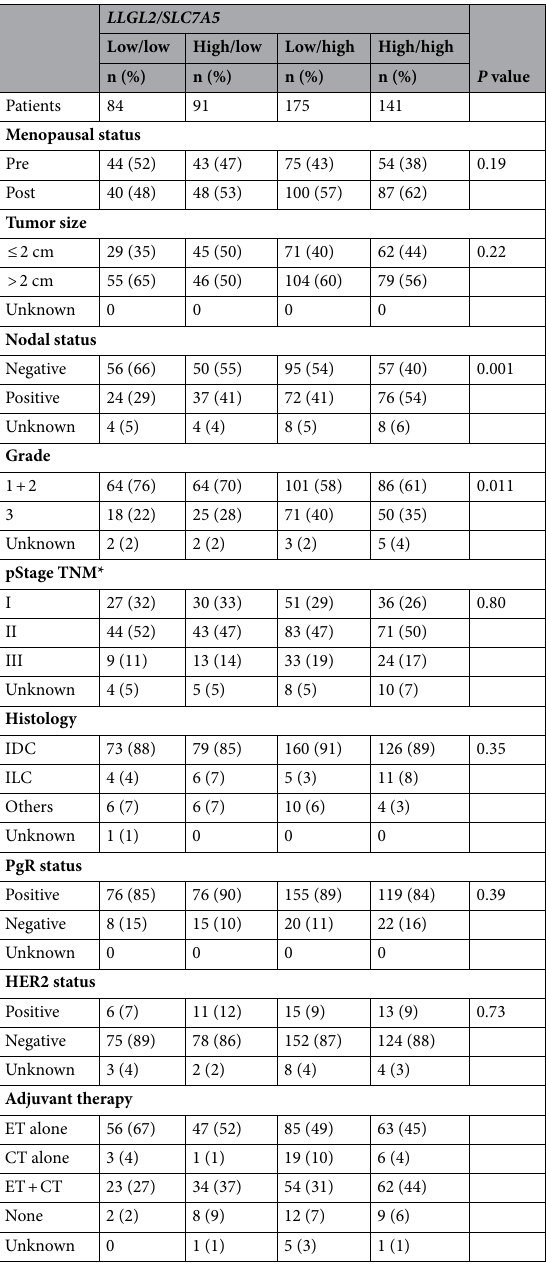
Table 1. Association between LLGL2 and SLC7A5 mRNA expression and clinicopathological characteristics in ERα-positive patients. PgR progesterone receptor, IDC invasive ductal carcinoma, ILC invasive lobular carcinoma, HER2 human epidermal growth factor receptor 2, ET endocrine therapy, CT chemotherapy. *AJCC